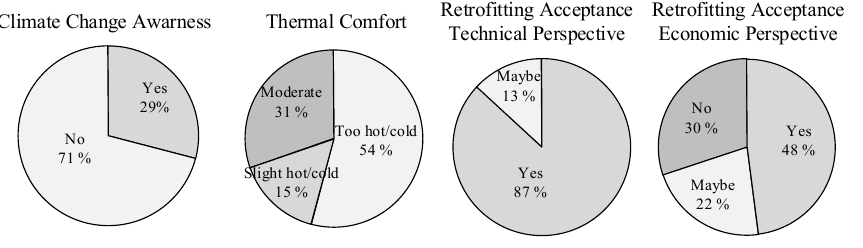
Fig. 8. The results of the open-ended